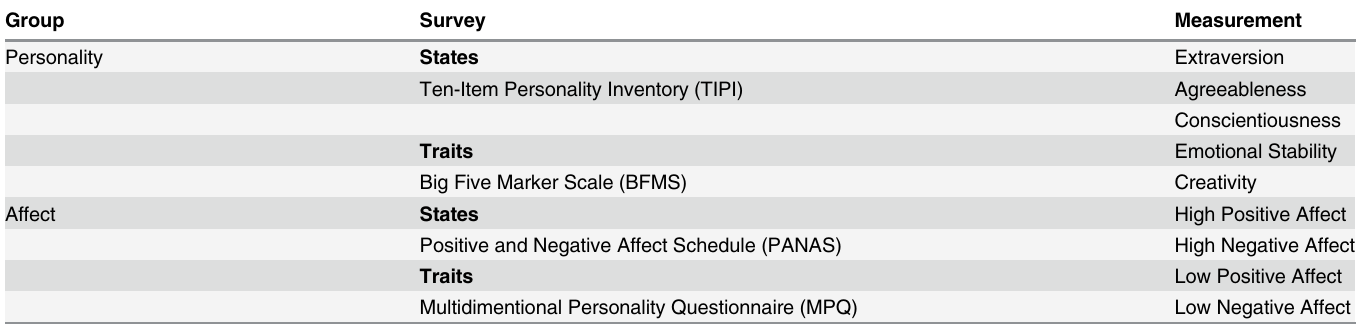
The short version of Positive and Negative Affect Schedule (PANAS) was used to evaluate the affective states of participants [60]. High positive affect (HPA) was assessed using 3 items: enthusiastic , interested and active . High negative affect (HNA) was assessed using 3 items: sad , bored and sluggish . Low positive affect was assessed using 2 items: calm and relaxed while low negative affect (LNA) was assessed using 2 items lonely and isolated . Table 1. Surveys for personality and affect states and